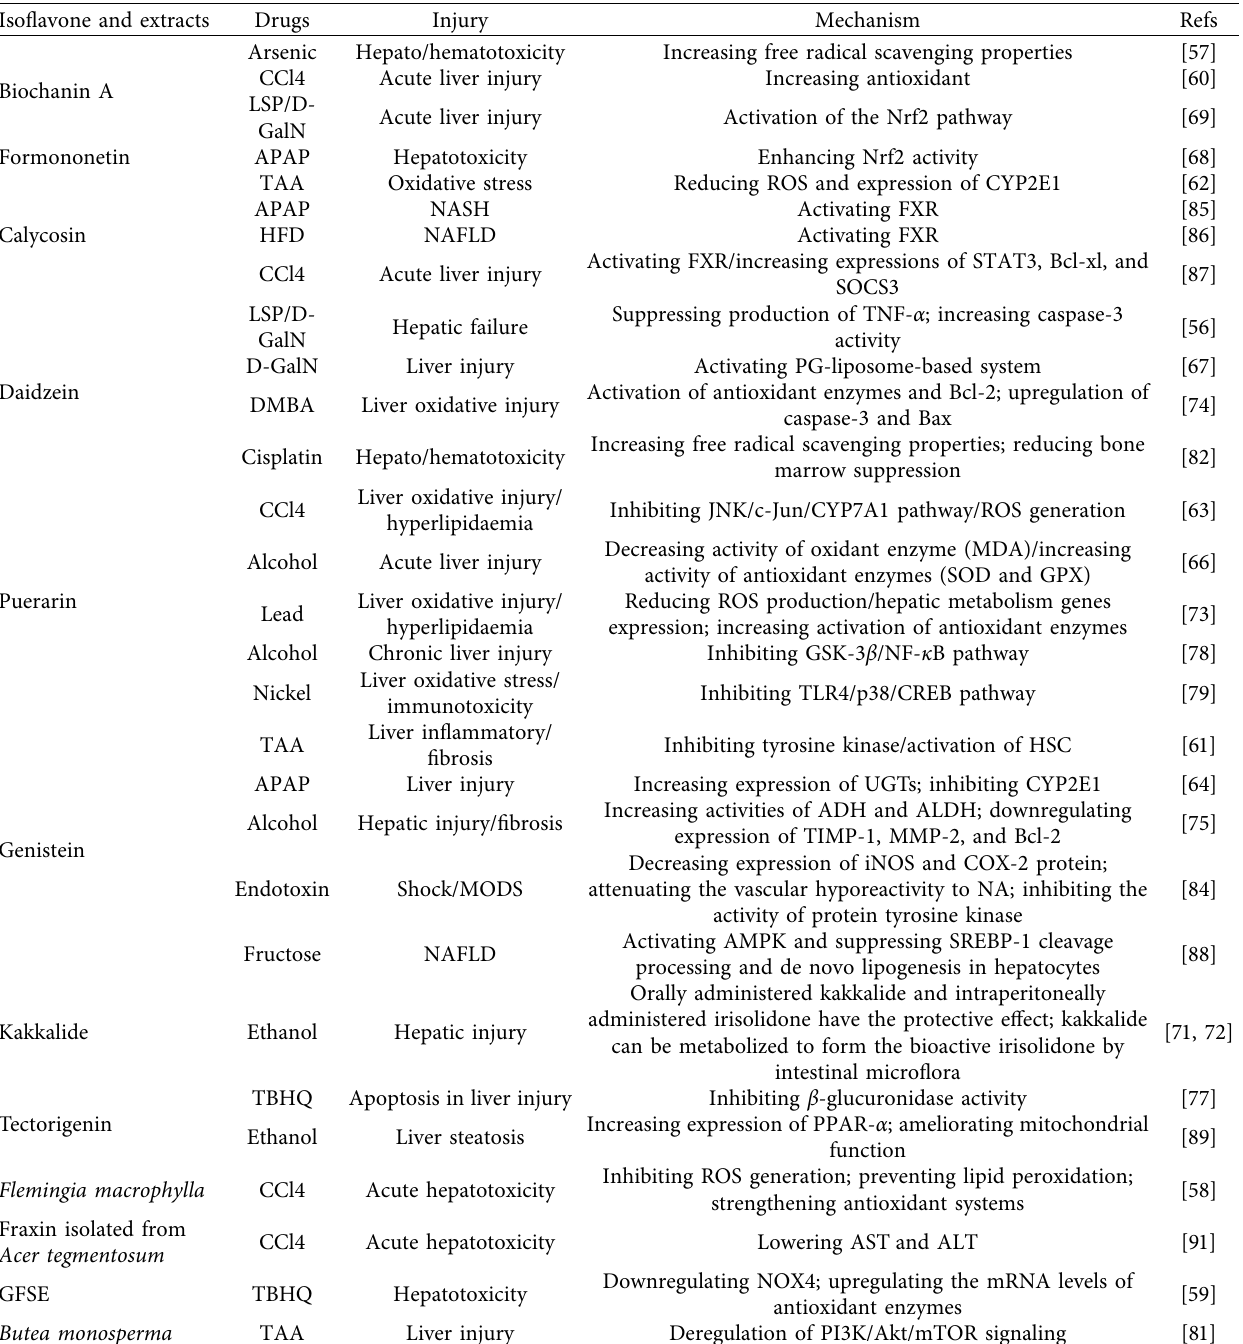
Table 1: Hepatoprotective effects of isoflavone and